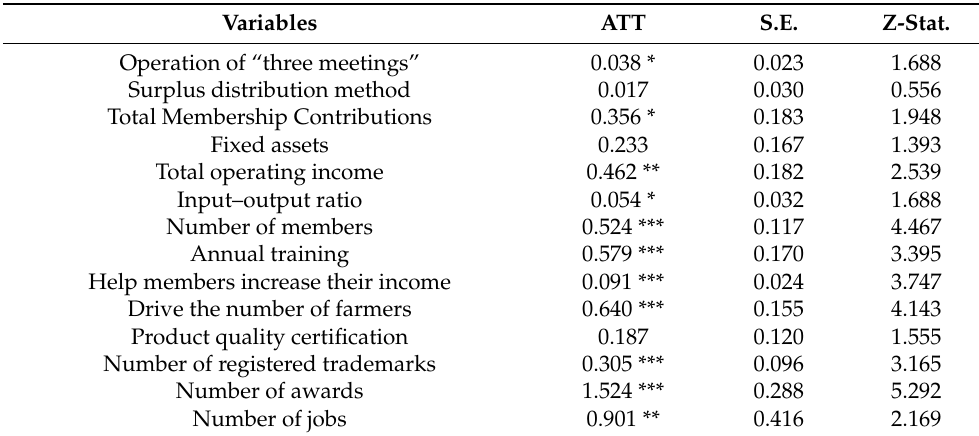
Table 8. IPWRA robustness test